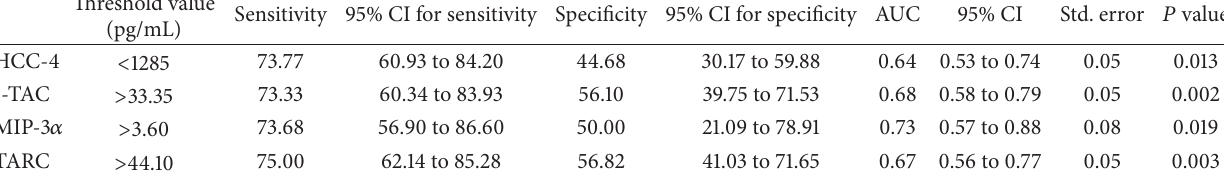
Table 3: Diagnostic values of chemokines.